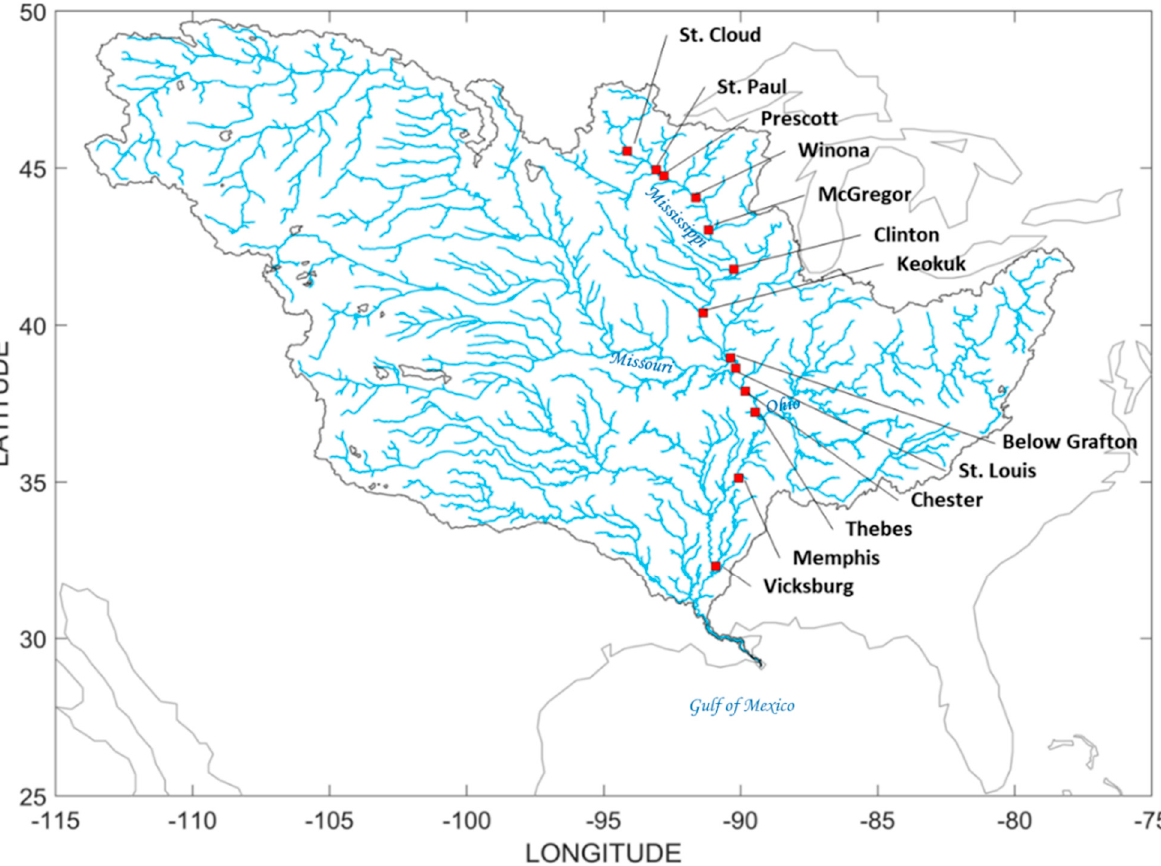
Figure 1. Geographical location of the Mississippi River, including spatial distribution of in-situ stations used in this study.